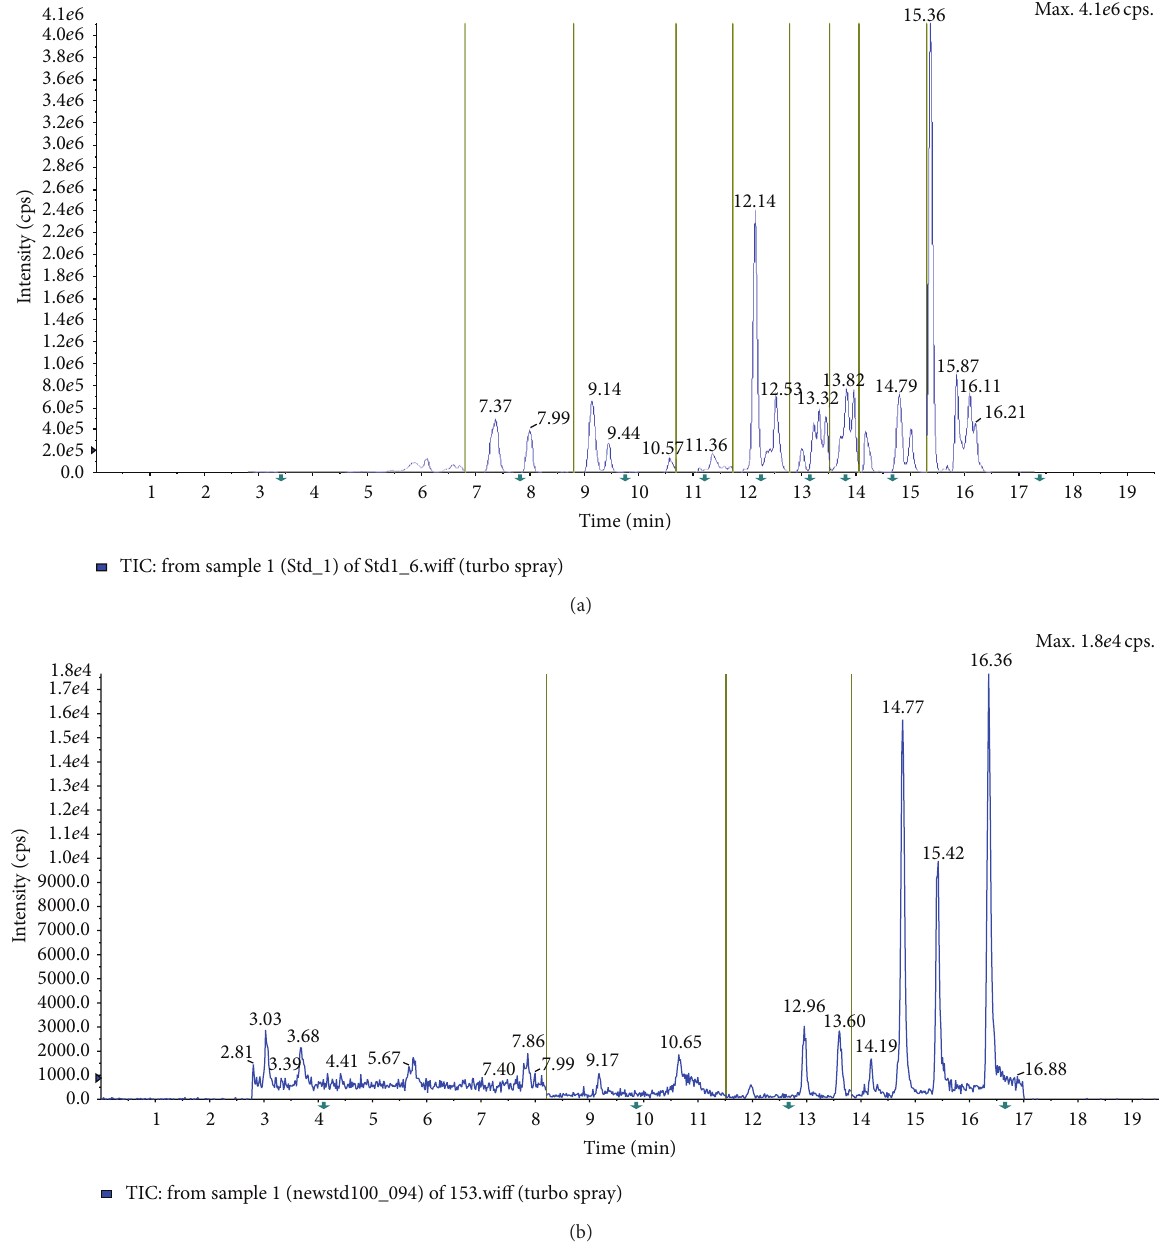
Figure 1: Total ions chromatogram (TIC) of 80 mycotoxins standards in positive mode (a) and of 21 mycotoxins standards in negative mode (b) obtained by HPLC-MS/MS